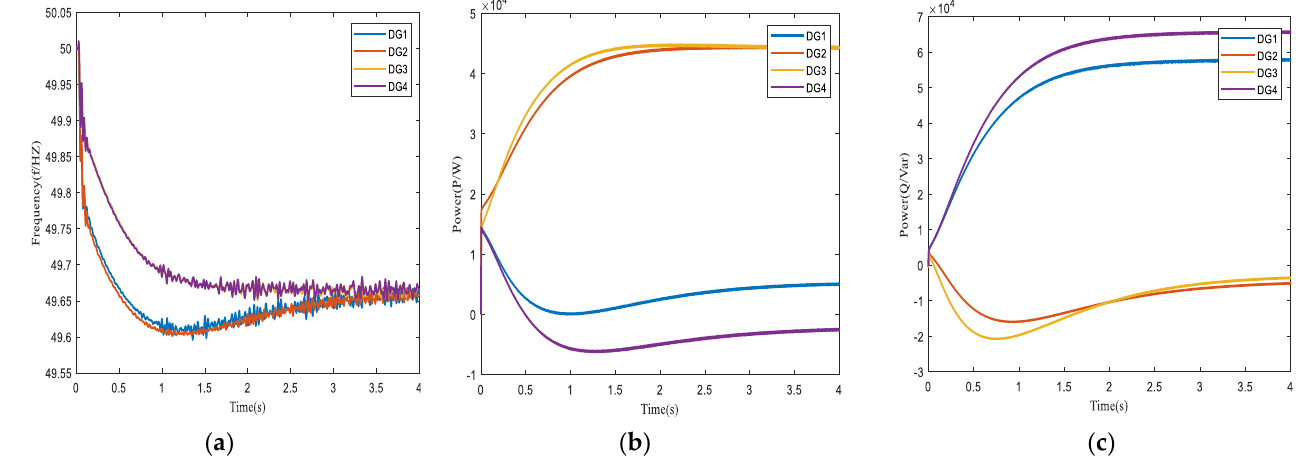
Figure 12. Parameter results of the microgrid system under primary droop control ( a ) Frequency variation of the system ( b ) Variation of active power of the system ( c ) Variation of reactive power of the system.